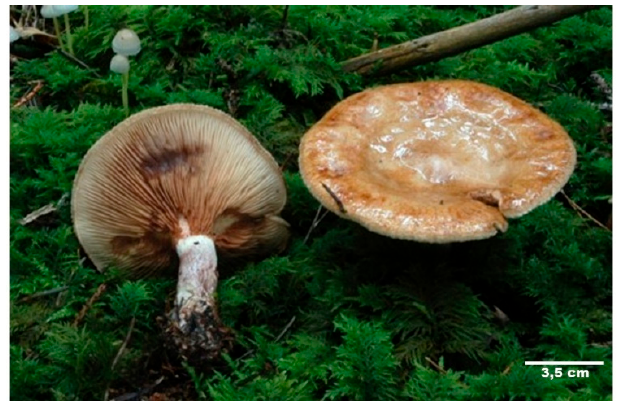
Figure 1. Image of Paxillus involutus (poison pax; brown roll-rim), photographed by mycologist and co-author, B. Haberl.